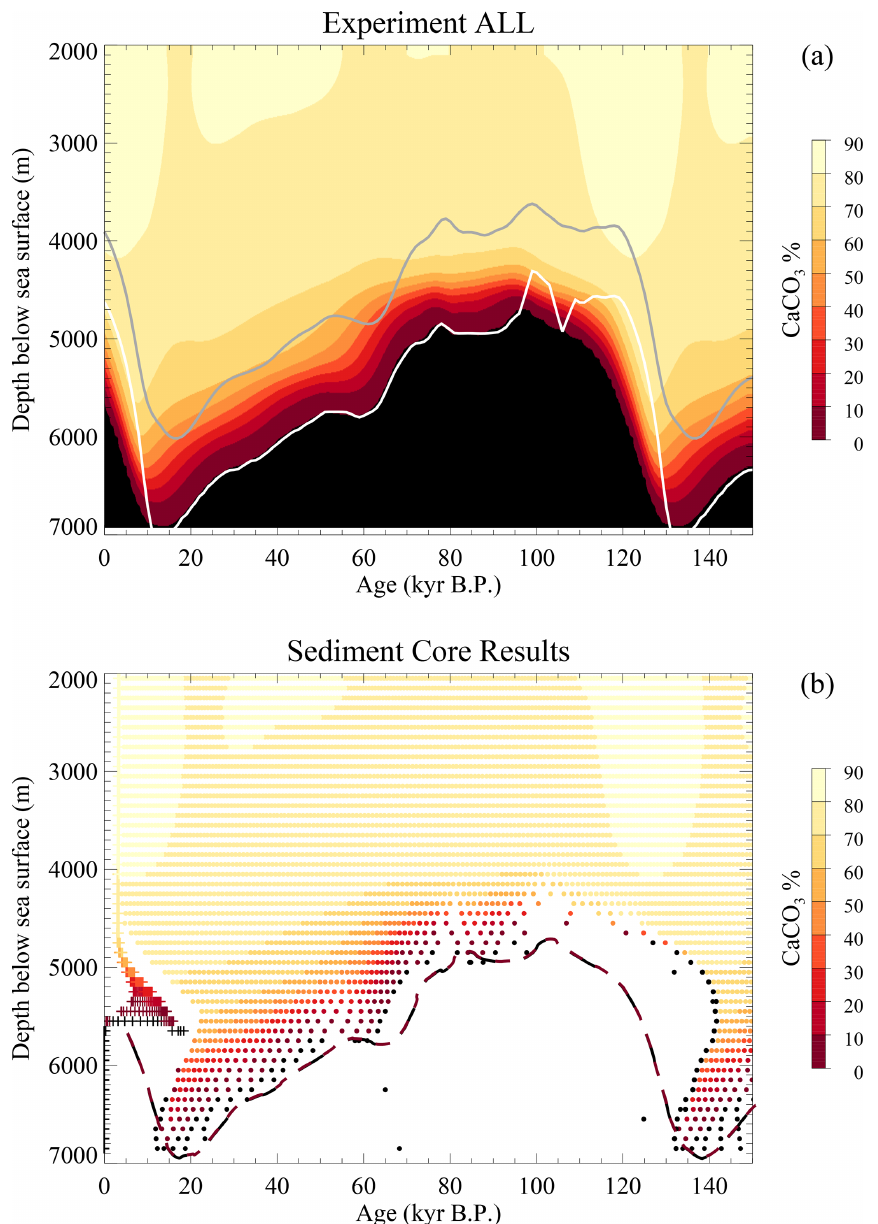
Figure 2. Average surface sediment CaCO 3 content for the ALL experiment from Munhoven (2007). (a) Actual surface sediment %CaCO 3 as a function of time. The grey line traces the evolution of the calcite saturation horizon (CSH), and the white line traces the carbonate compensation depth (CCD) at which the dissolution rate equals the deposition rate. (b) Synthetic sediment core record from cores “drilled” at 100m sea-floor depth intervals from 2050 to 6850mb.s.l. in the low-latitude Indo-Pacific box as a function of age of the layers. The long dashed line indicates the limit between the black and maroon zones in panel (a) , shifted by 5kyr to the